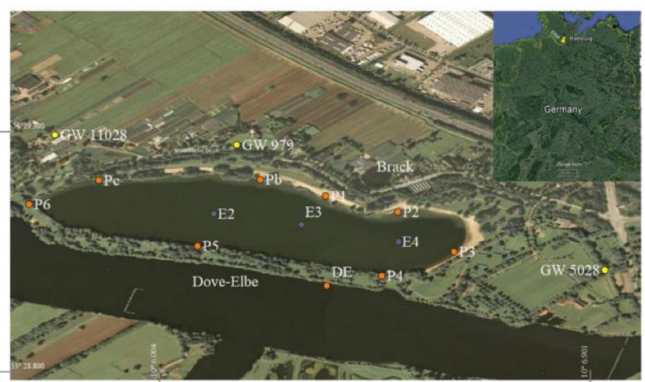
Figure 1. Location of Eichbaumsee close to Hamburg; E2, E3, and E4 indicate water column and sediment core sampling locations; P1–P6, Pc, and Pb are the push-point sampling locations; DE in- dicates the Dove-Elbe sampling location; GW979, GW5028, and GW11028 indicate the locations of groundwater wells; Brack is a small lake north of Eichbaumsee (Source of images: GeoFly.de, and Google Earth).